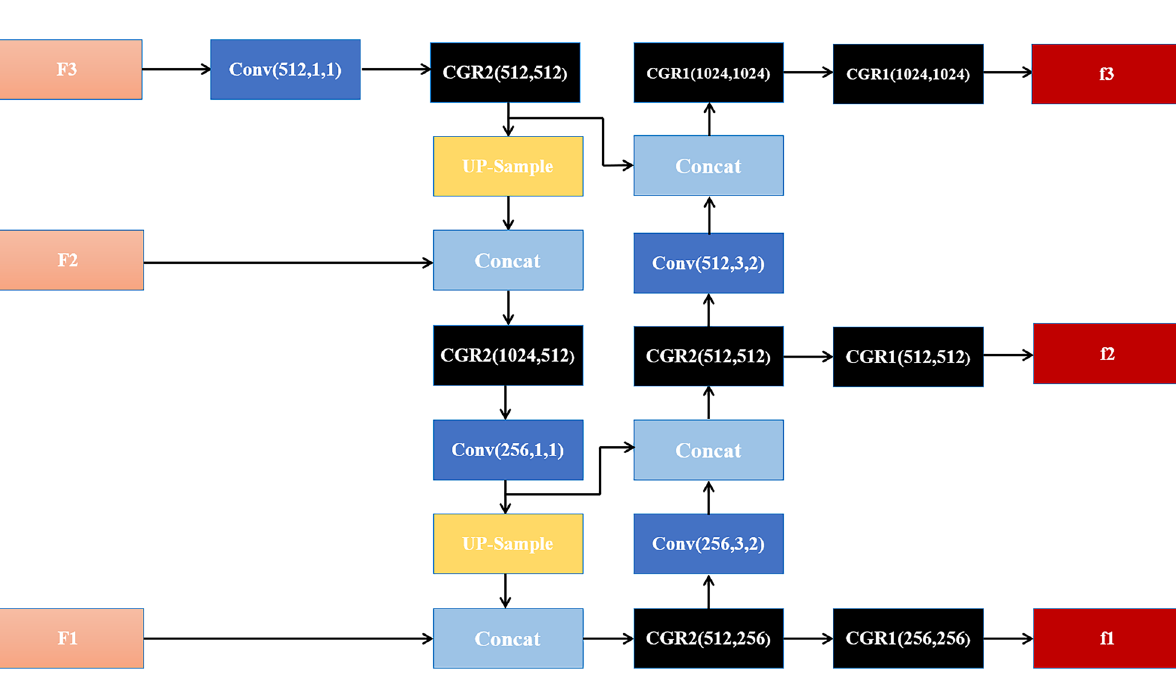
Figure 9. The network of